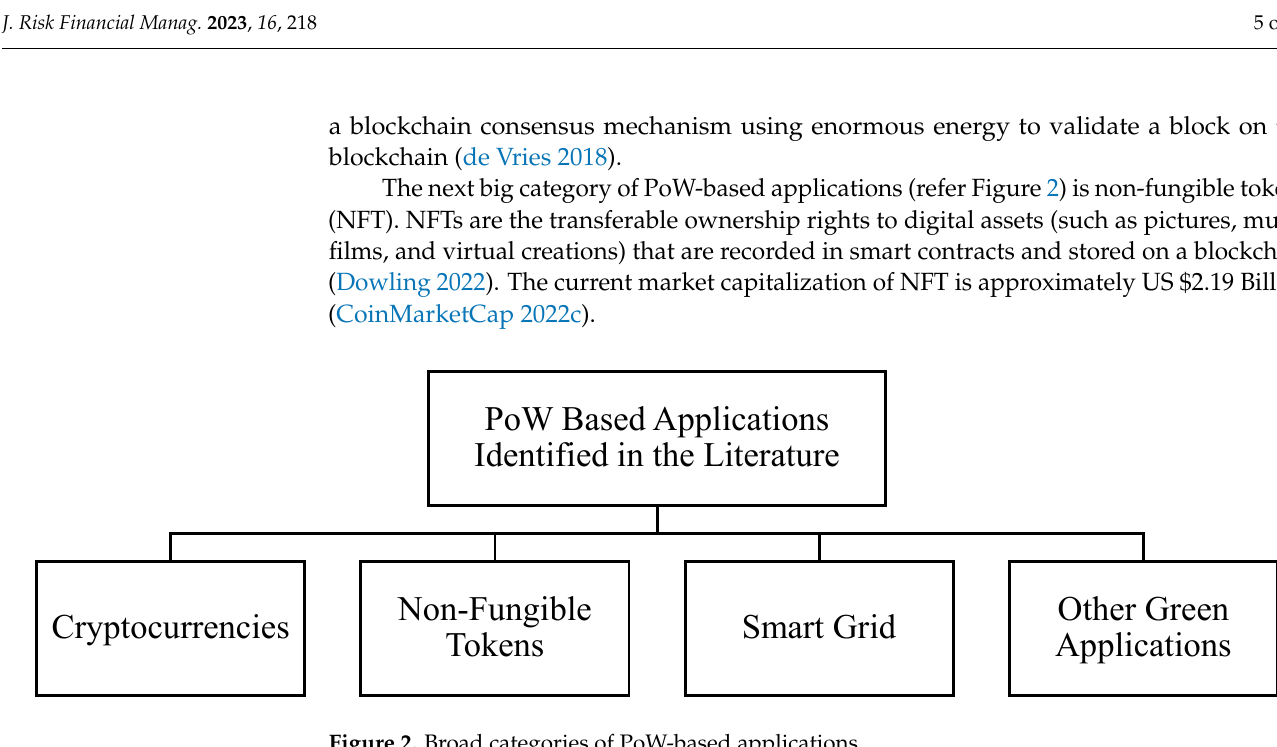
Figure 2. Broad categories of PoW-based applications.